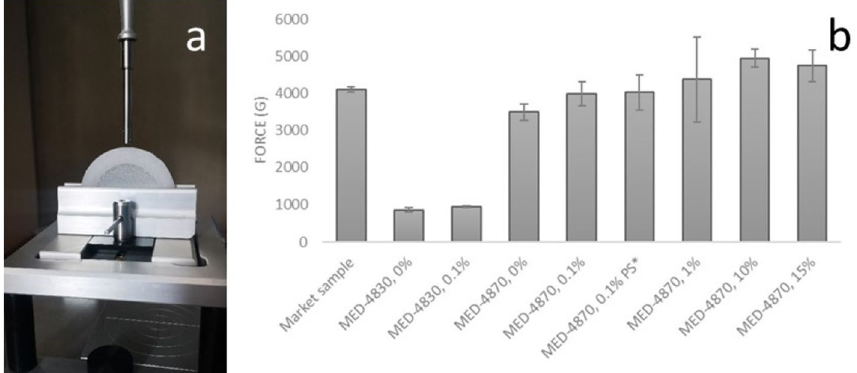
Figure 4. Compression test of silicone rings: ( a ) Compression probe and holder in texture analyser; ( b ) Compression forces in market sample and customised silicone rings (n ≥ 3 ± SD ) . PS* post submersion—treated with SVF (pH 4.2) for a period of 4-month at 35 ± 2 °C.